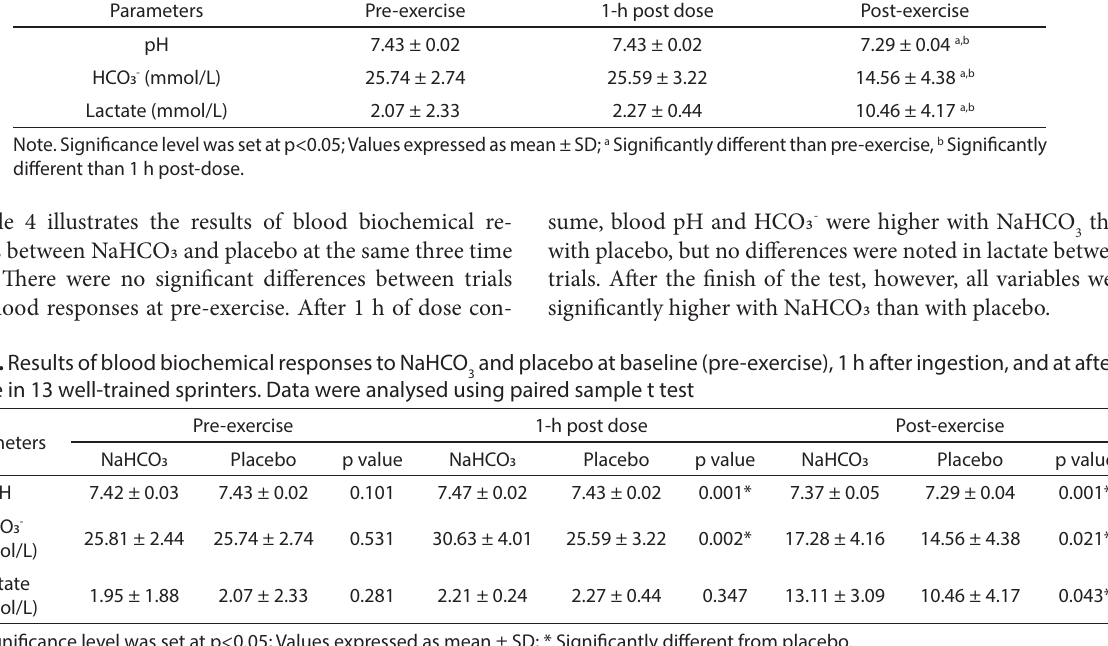
Table 3. Results of blood biochemical responses to placebo at baseline (pre-exercise), 1 h after ingestion, and at after exercise in 13 well-trained sprinters. Data were analysed using one-way ANOVA